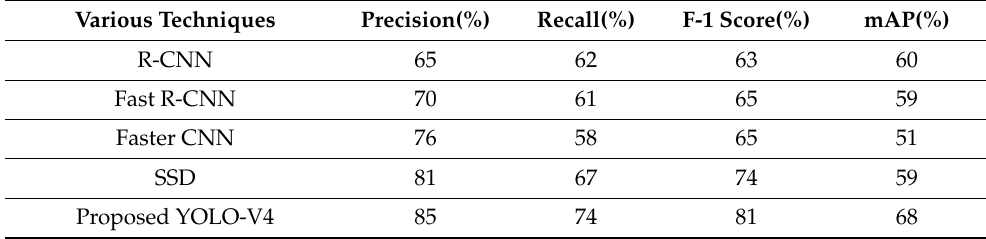
Table 3. Performance comparison of object detection techniques on the CUSTOM